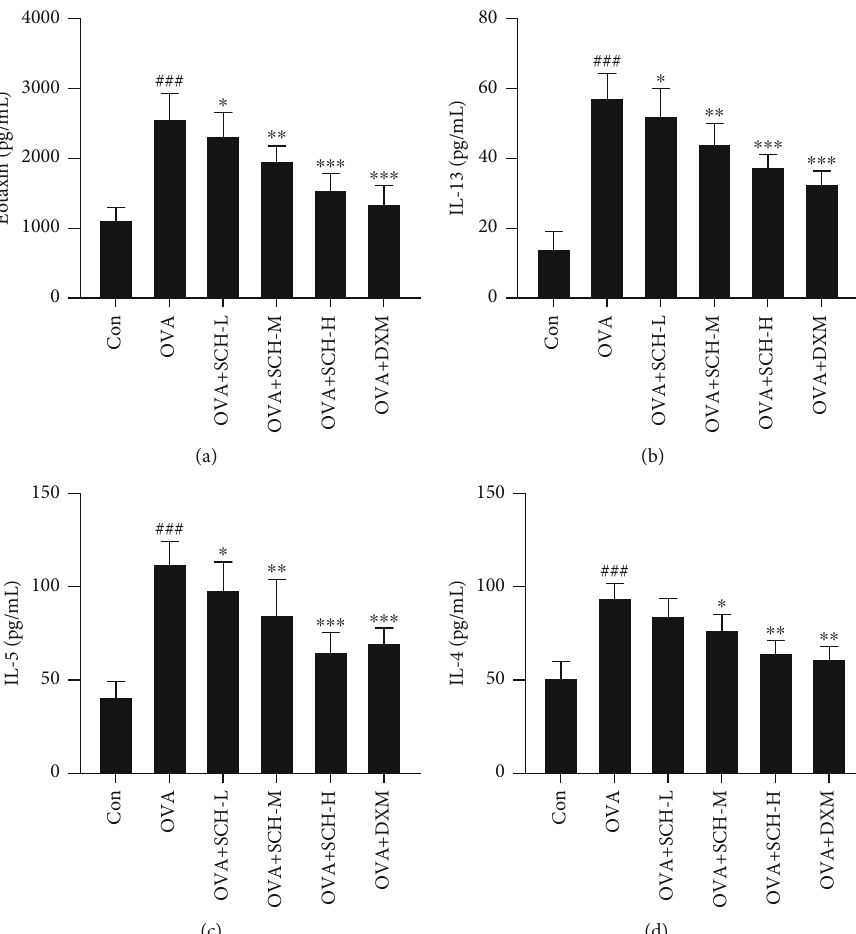
Figure 3: E ff ect of SCH on the airway levels of in fl ammatory factors. Samples of BALF were collected to detect the levels of (a) eotaxin, (b) IL- 15, (c) IL-5, and (d) IL-4 via using ELISA. Data are reported as the means ± SD ; n = 6 . ### p < 0 : 001 and ## p < 0 : 01 compared with the control group; ∗∗∗ p < 0 : 001 , ∗∗ p < 0 : 01 , and ∗ p < 0 : 05 compared with the OVA group.